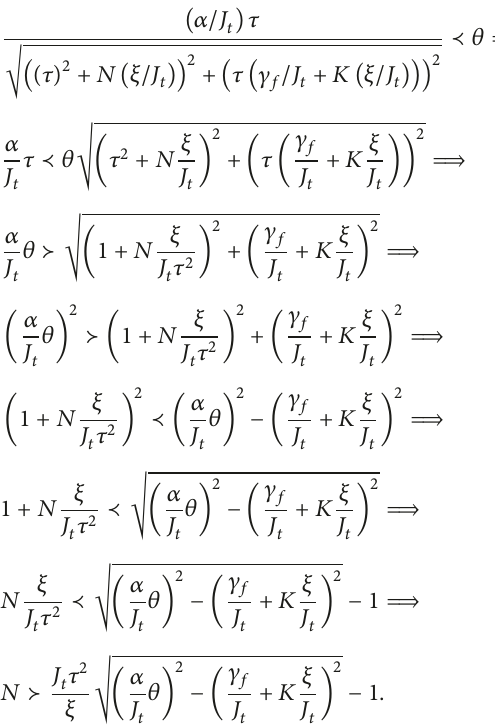
of the method, the distance (according to the ordinates axis) between two points on the curve is considered. The first point is P1 with abscissa 143 seconds and the second point P2 with 90.34 seconds of abscissa. In the nominal situation, the difference between the ordinates of P1 and P2 is of 8.1 rpm; this value becomes 11.5 rpm in the faulty situation. By using the fault tolerant control strategy, this value is reduced to 9.2 rpm. As shown in the same Figure 10, not only the dynamics are impacted but also the steady state value of the rotor speed which become closer to 40 rpm operating point due to the integral term 𝑁 ∫(𝛿Ω 𝑟𝑓 − 𝛿Ω 𝑟 ) in the control